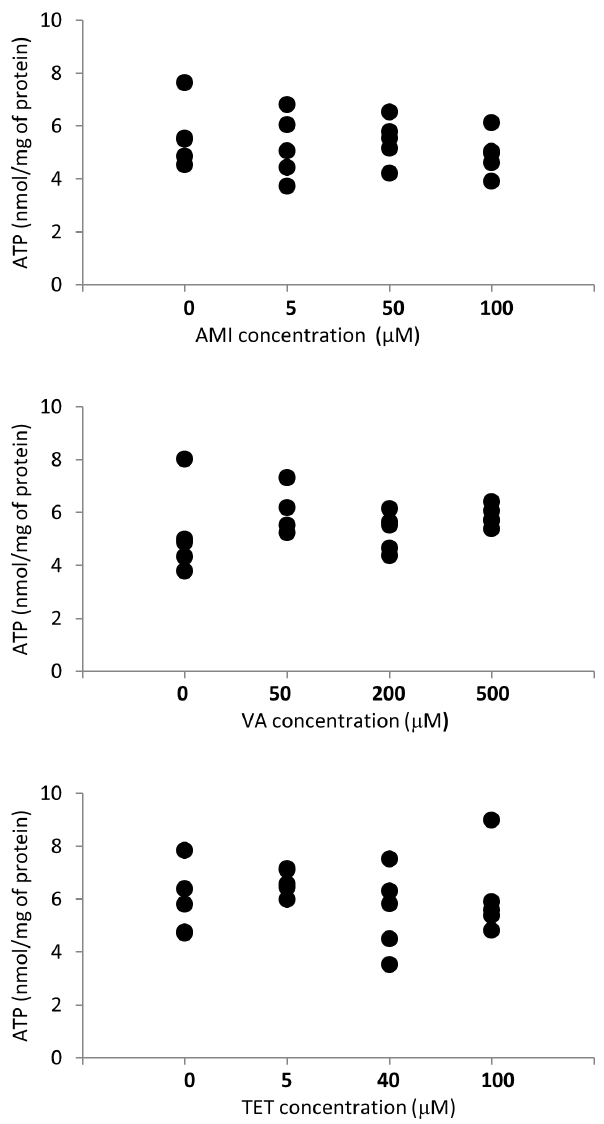
Figure 1. Viability of mouse liver slices upon treatment with steatogenic drugs. Liver slices were incubated for 24 h with preselected concentrations of amiodarone (AMI) 25, 50, and 100 m M, valproic acid (VA) 50, 200, and 500 m M, and tetracycline (TET) 5, 40, and 100 m M. ATP content (nmol/mg of protein) in slices treated with different concentrations of hepatotoxicants was compared to control slices. Each point is the mean 6 SD of 5 independent experiments (liver slices were isolated from livers of 5 mice) and each measurement was made in duplicate. There were no significant differences between the tested